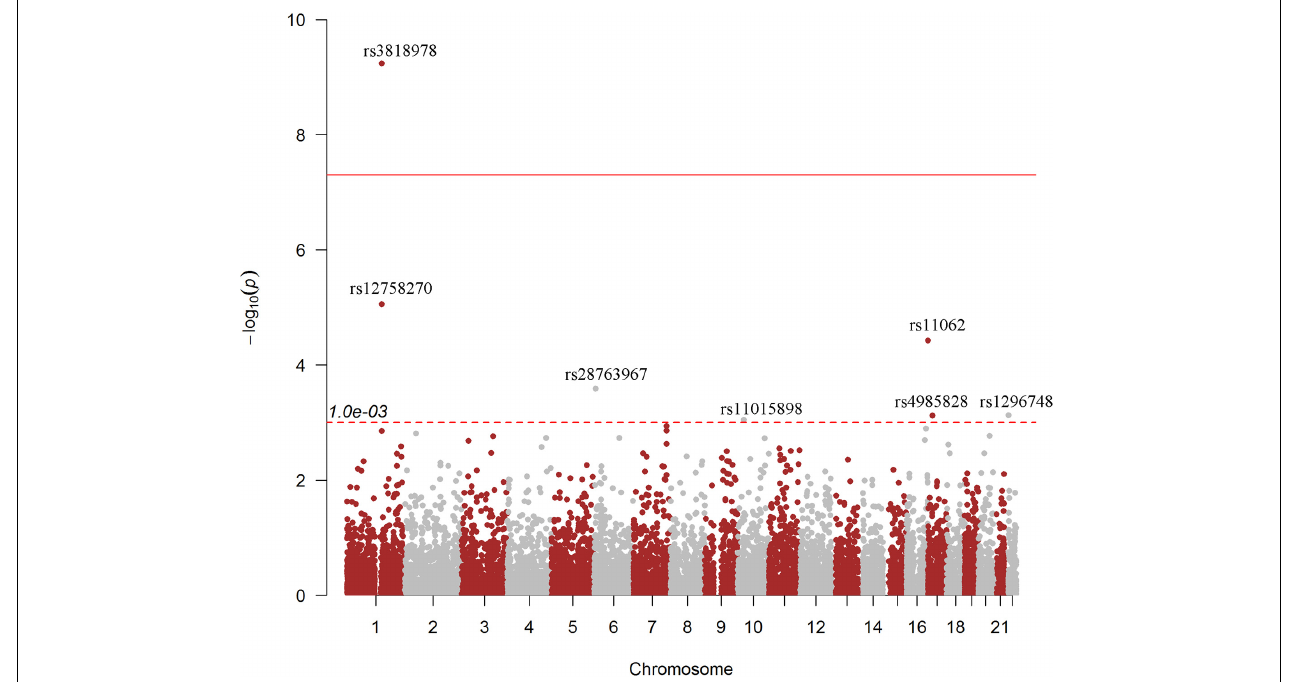
FIGURE 1 | Genome-wide associations between RNA modification-associated single-nucleotide polymorphisms (RNAm-SNPs) and spontaneous coronary artery dissection (SCAD). This Manhattan plot shows the associations between RNAm-SNPs and SCAD. The x -axis indicates chromosome positions. The y -axis indicates –log 10 p -values of the associations. The information was extracted from the summary dataset of the SCAD genome-wide association study (GWAS) published in 2020 (Saw et al., 2020). The solid red line indicated the genome-wide significance level of 5.0 × 10 − 8 , and the dotted red line indicated the suggested level of 1.0 × 10 − 3 . The brown and gray color dots were used to separate them from each